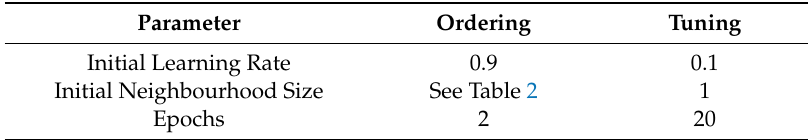
Table 1. Parameters for the self-organizing map (SOM)-based stratified random data splitting (SBSS)